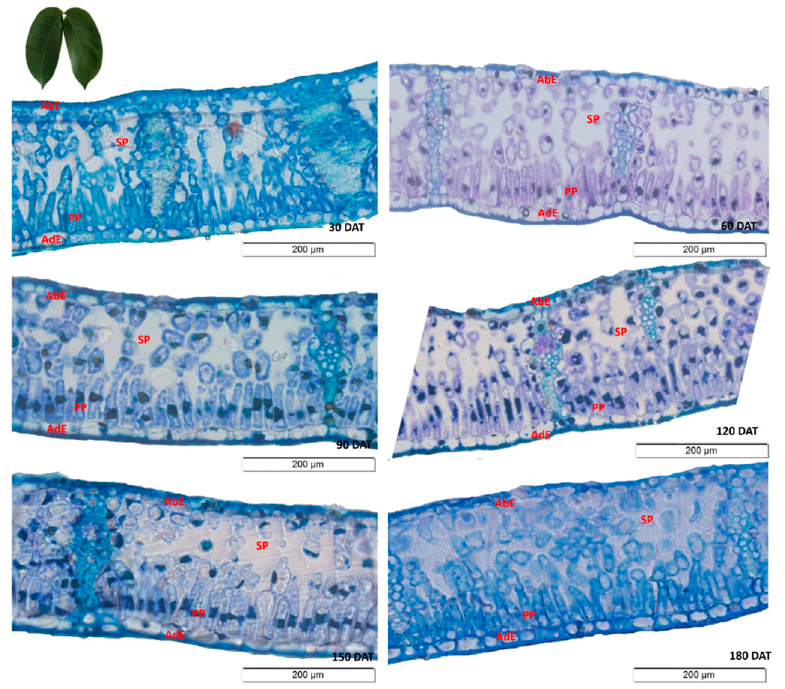
Figure 2. Transverse sections of the leaves of the seedlings of Hymenaea courbaril L. cultivated in a hydroponic system, showing the different anatomical regions (AbE = Abaxial Epidermis; AdE = Adaxial Epidermis; PP = Palisade Parenchyma; SP = Spongiform Parenchyma). Sections obtained at 30-day intervals across the initial development of the plants (30, 60, 90, 120, 150, and 180 days after transplantation).